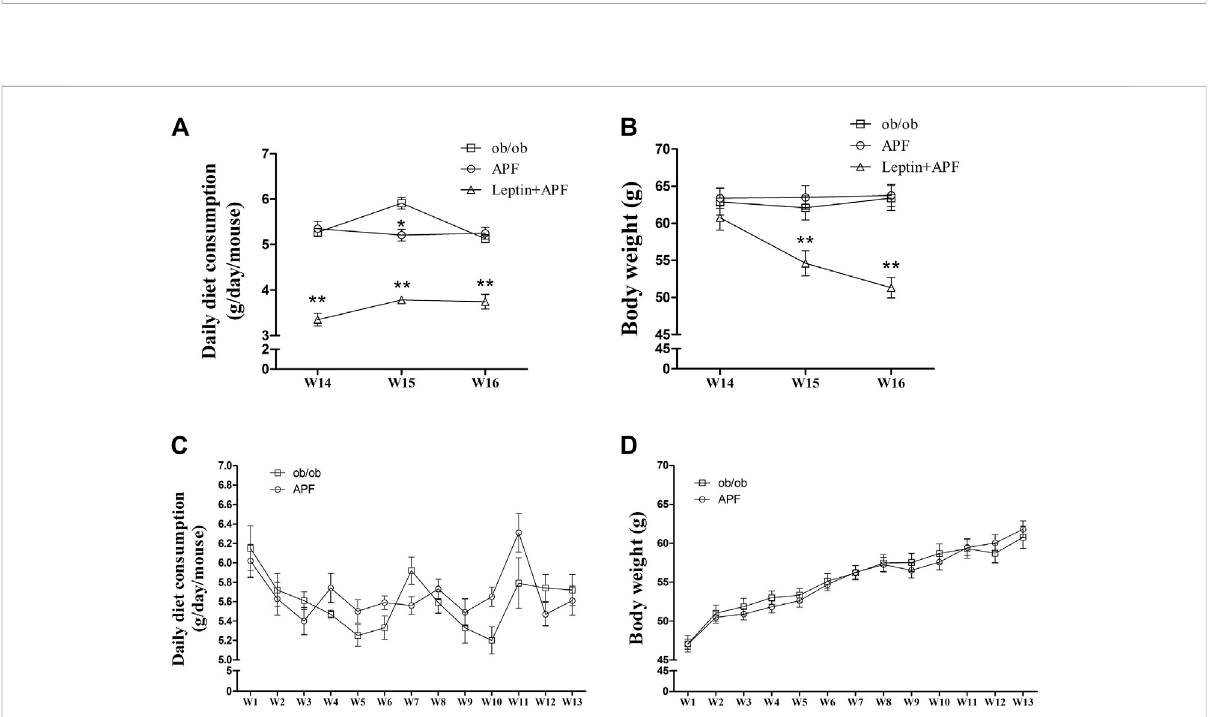
Effects of APF and supplementary Leptin on ob/ob mice. Daily diet consumption (A,C) , body weight changes (B,D) of ob/ob group (white squares), APF group (white cycles) and APF + leptin group (white trigons) after treatment with APF 16 weeks or APF + letpin 3 weeks. Values are means ± SEMs, n = 7 – 8 per group. * p < 0.05, ** p < 0.01 versus ob/ob